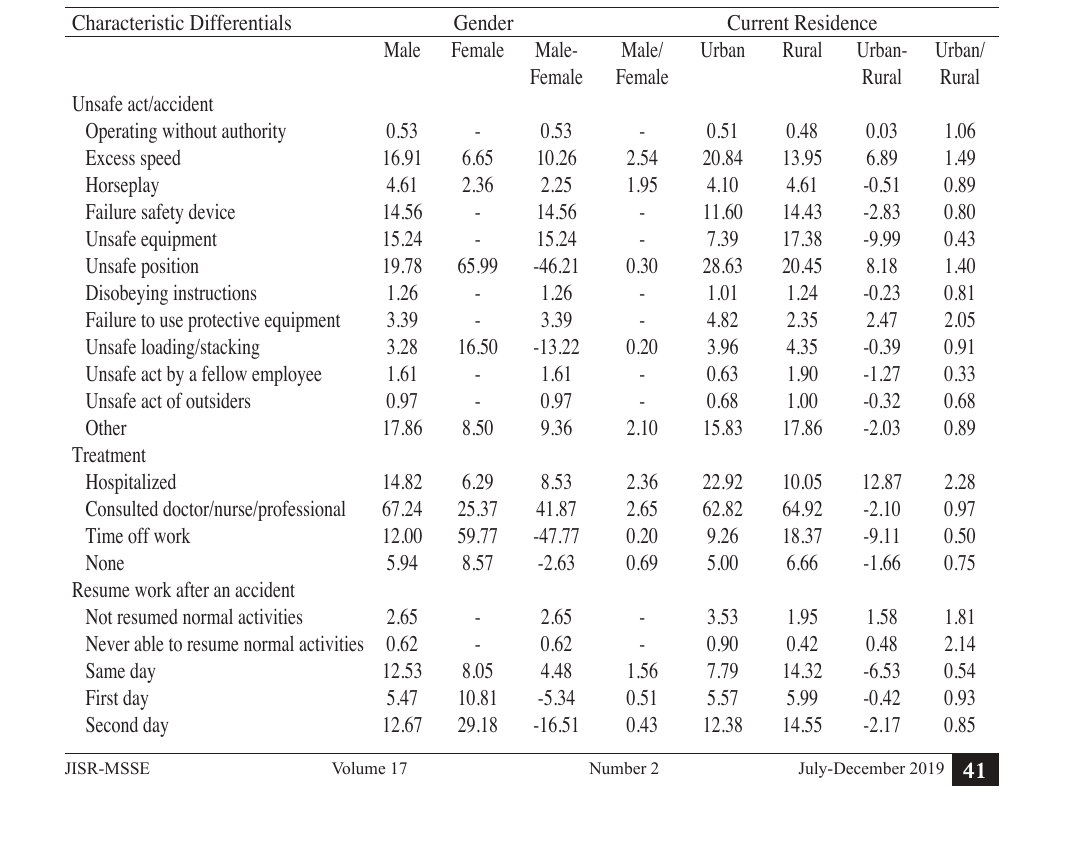
Proportions of the work-place characteristics, treatment of occupational injuries, and days to resume work by gender and current residence of internal migrant